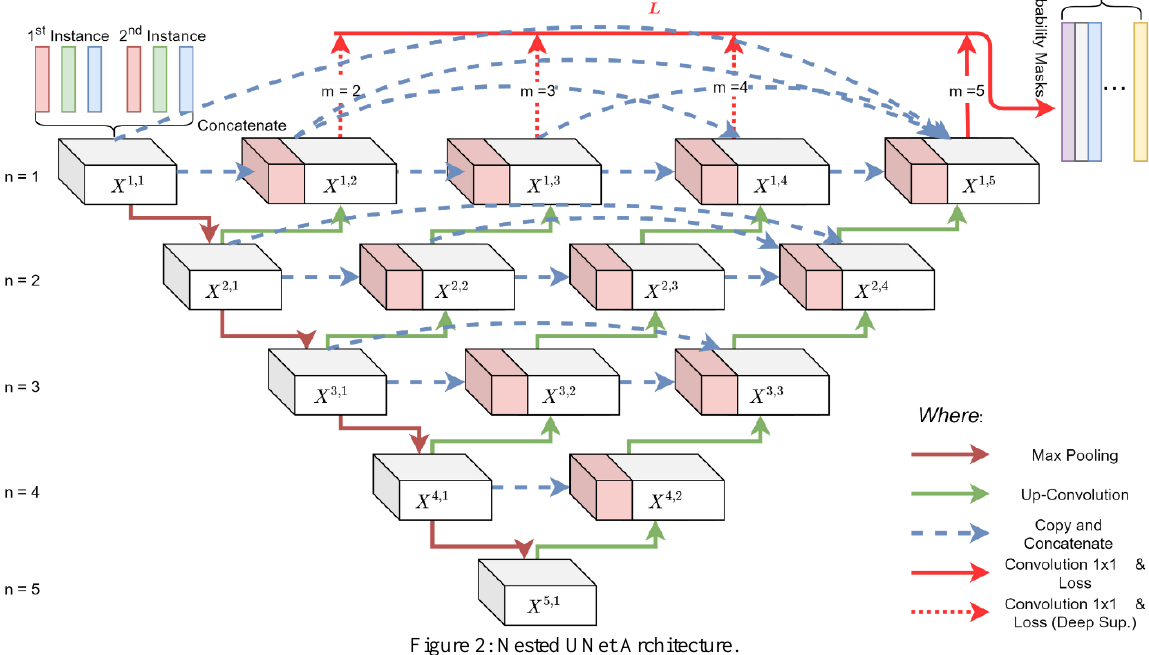
Figure 2: Nested UNet